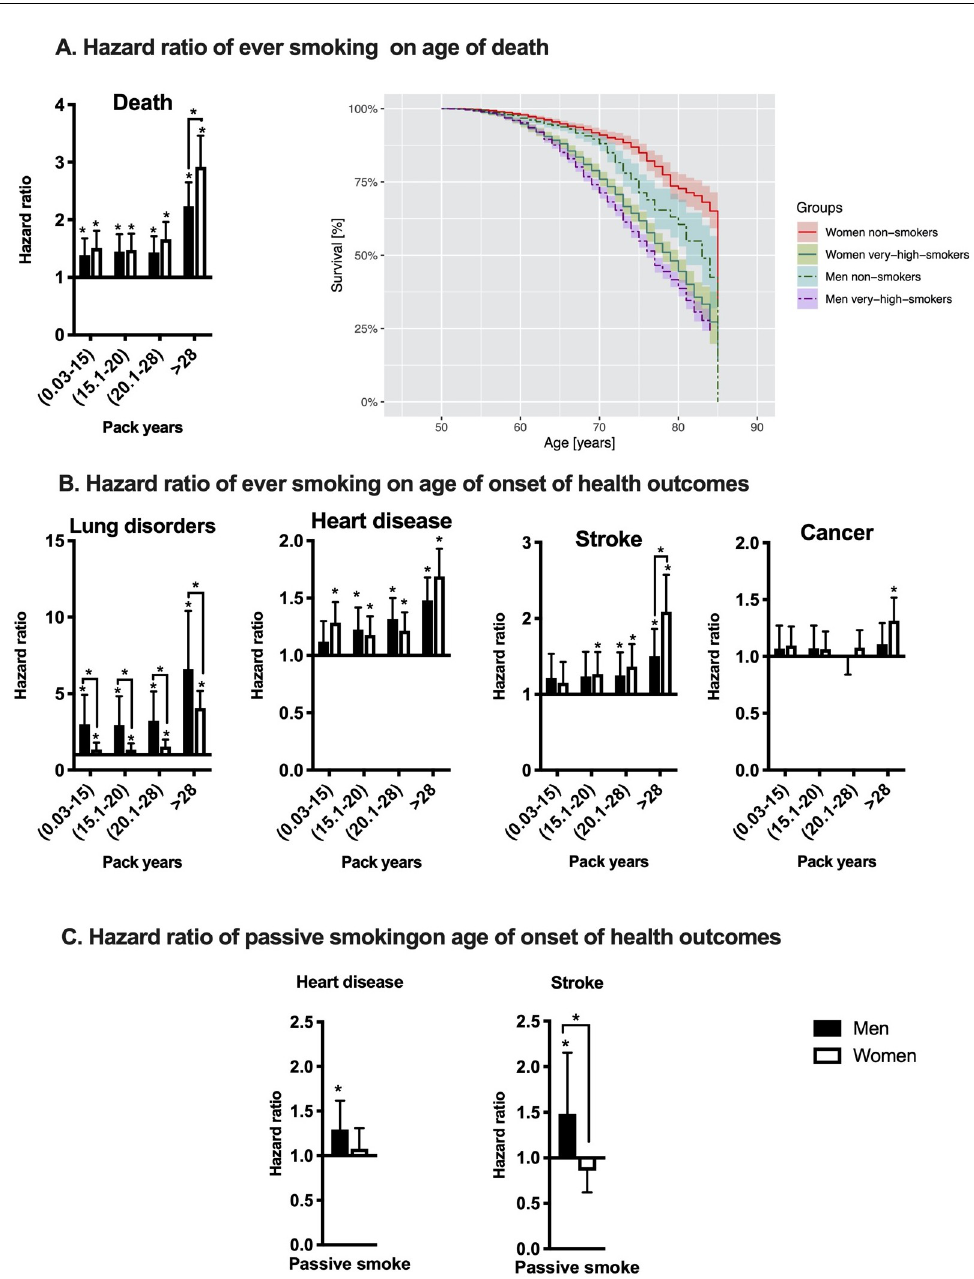
Fig 1. Smoking hazards are modified by sex for earlier age of death, and earlier onset of lung disorders, and stroke. A) The smoking pack-years hazard and Kaplan-Meier survival curves for all-cause mortality in men and women between 50–85 years old age in HRS. The hazard ratio (HR) of smoking pack-years (B) and passive smoke (C) on health outcomes. HRs are calculated using Cox proportional hazard models separately by sex. � p-value < 0.05 based on Wald test in the models. The significant sex differences are based on the interaction terms in the full model and are indicated in each figure. The stratified models were adjusted for ethnicity. The baseline effects of sex are reported in Tables 1 and 2.